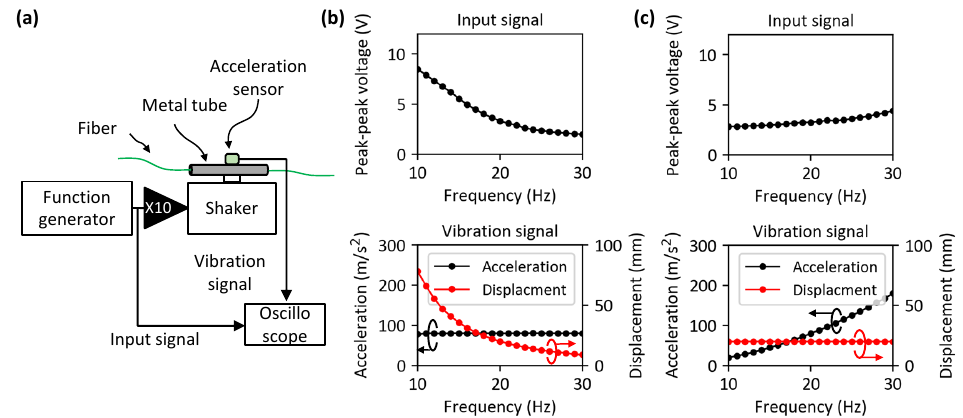
Fig. 3 (a) A block diagram to characterize the vibration response of the metal tube attached to the shaker. A capacitive acceleration sensor combined with a transducer and an oscilloscope was used to measure the acceleration applied to the